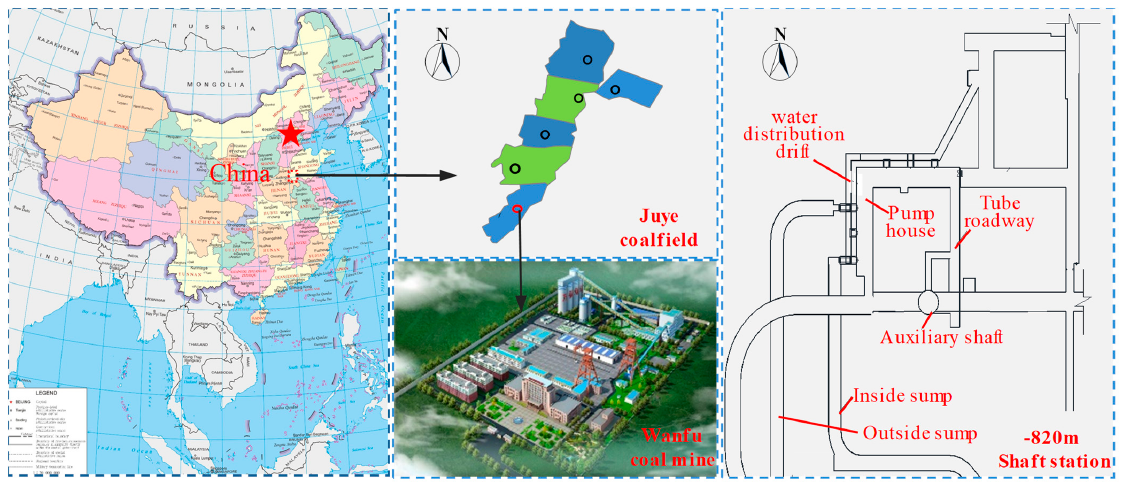
Figure 1. Mine location and − 820 m shaft station plan.